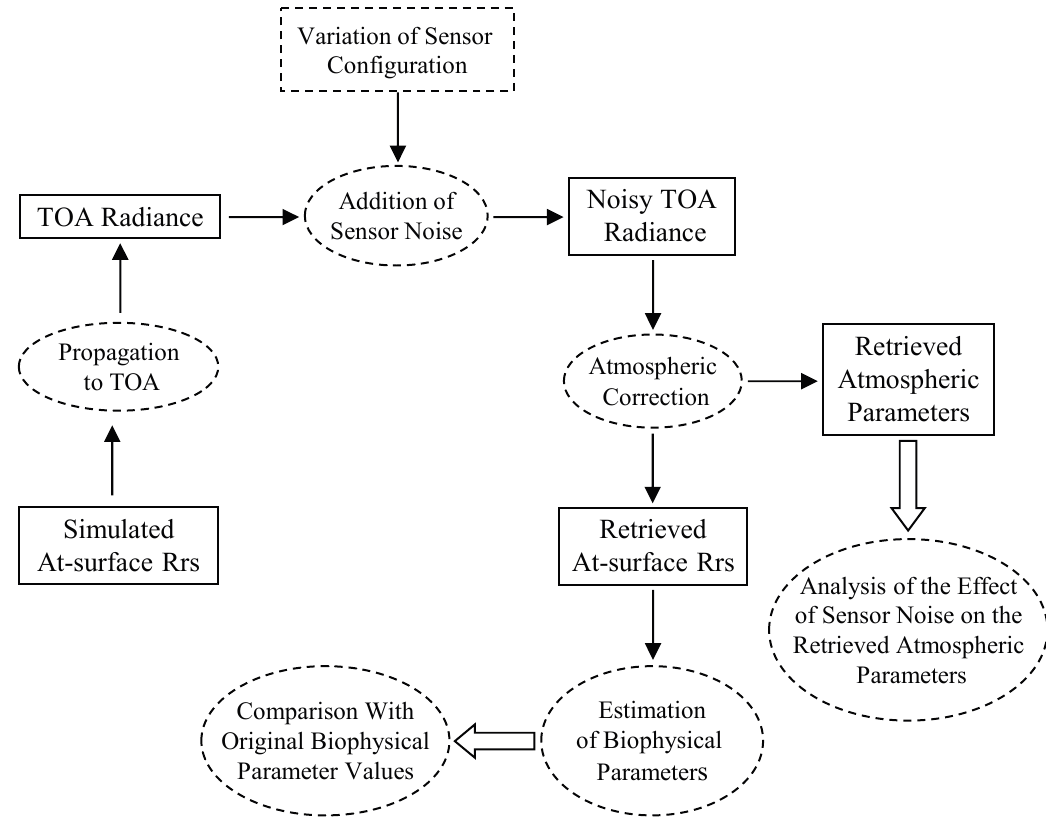
Figure 1. Flow chart of the data processing steps (TOA: top of